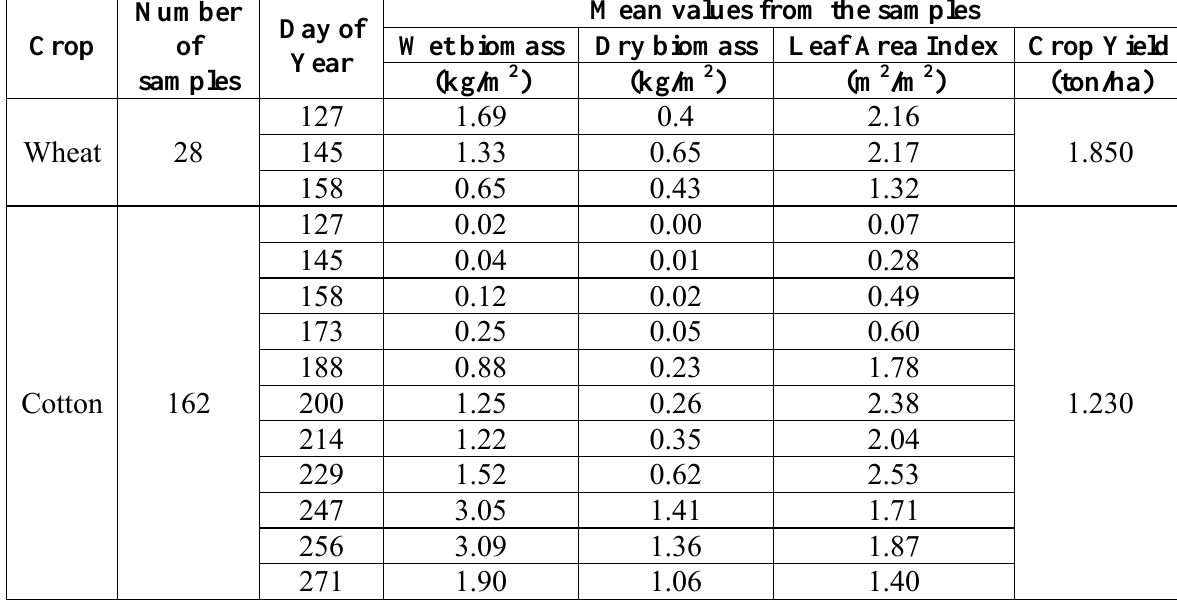
Table 3. Field-plot data characteristics of various variables for different